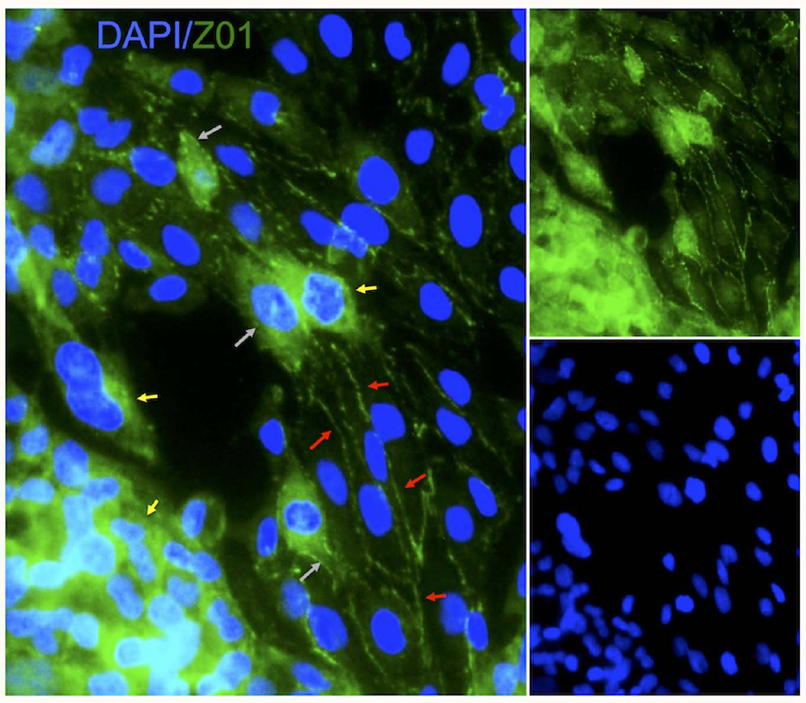
Figure 4. Quantification of endothelial morphogenesis. (A) A distinctive neurovascular cytoarchitecture emerged in which hCMECs (CD31 + ) formed vasculature-like structures (VLS) resembling a vascular network in between patches of hNSCs (polyclonal GFAP + ). (B) The efficiency of VLS formation was quantified by measuring the length of segments between VLS branching points. (C) In a few samples, singular capillary-like structures comprising single layers of CD31 + cells between which a lumen-like space formation was observed. Diamidino-2-phenylindole (DAPI, blue) serves as a nuclear counterstain. Scale bars represent 50 m m.